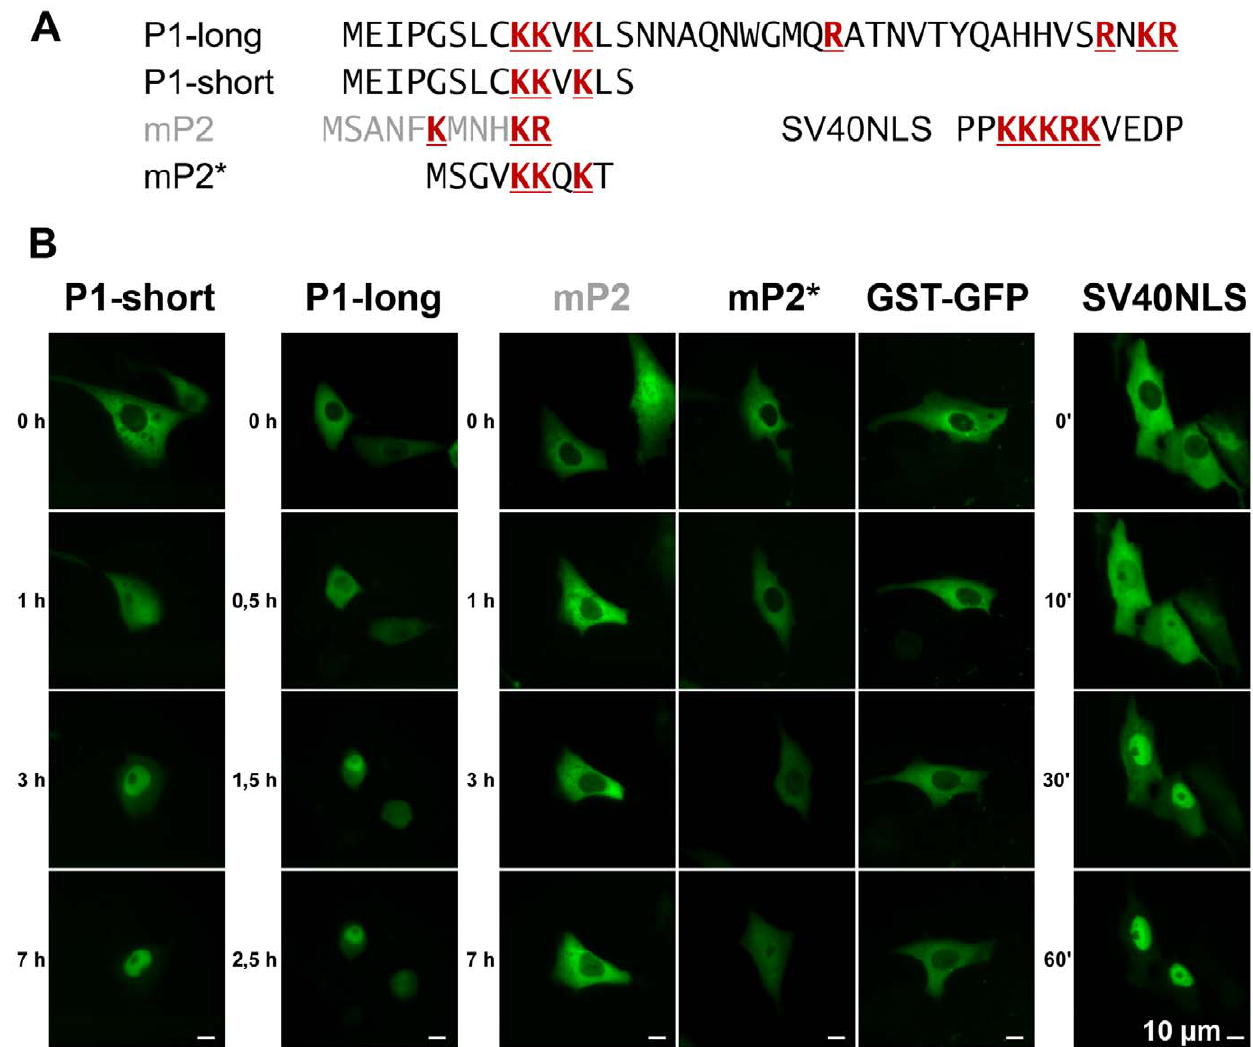
Figure 7. The KKxK motif shows import activity. Two peptide variants of the N-terminus of human PAPSS1 differing in length (long and short) as well as the peptides encoded by the first exon of murine PAPSS2 were tested as GST-GFP transport substrates in microinjection experiments. A , peptide sequences of the transport substrates tested. B , both recombinant GST-PAPSS1 N-term -GFP proteins showed import activity upon microinjection into the nuclei of Vero cells at the indicated time points (left panels). In contrast, an N-terminal peptide derived from murine PAPSS2 (mP2) remained cytosolic as microinjected GST-GFP alone under the same experimental conditions, whereas an N-terminal peptide of an alternatively spliced murine PAPSS2 (mP2*) displayed weak import activity (middle panel). As a positive control, the nuclear localisation signal of the SV40 T- antigen (SV40NLS) was completely imported into the nucleus within 60 min following microinjection (right panel). Approximately 50 cells were injected, and representative examples are